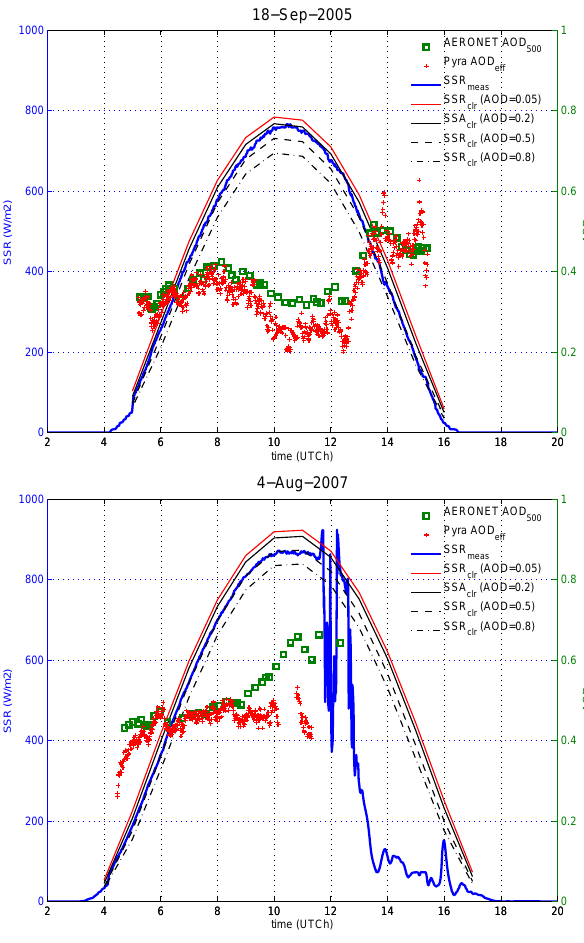
Fig. 1. Thessaloniki SSR (surface solar radiation) and AOD (aerosol optical depth) for selected days. The figure shows the effective AOD derived from SSR data (red crosses), the AERONET AOD at 500nm (green open squares), the measured SSR (blue curve) and clear-sky simulated SSR for various aerosol loads (SSR curves for an AOD of 0.05, 0.2, 0.5, and